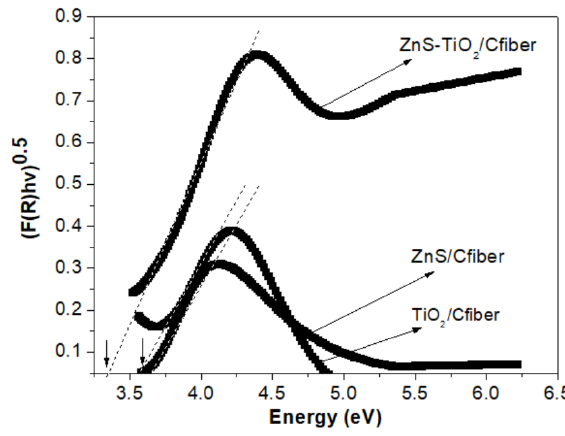
/C-fiber, (b) and (c) ZnS-TiO 2